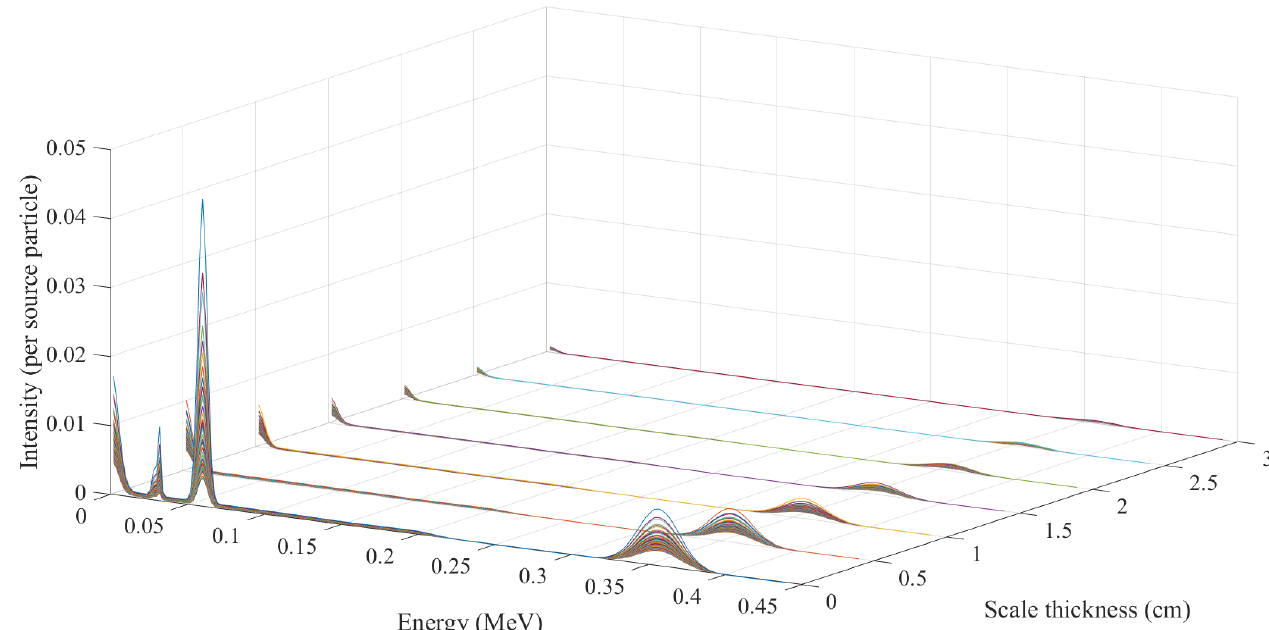
Figure 2. The signal received by the NaI